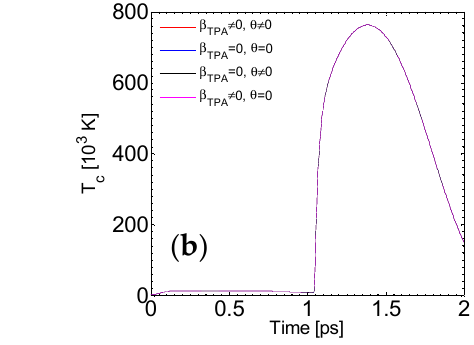
Figure A1. Evolution of values of carrier for E p = 50 mJ / cm 2 and 125 mJ / cm 2 for (001) and (100) crystal orientation at x = y = 0 and on the surface of the material.